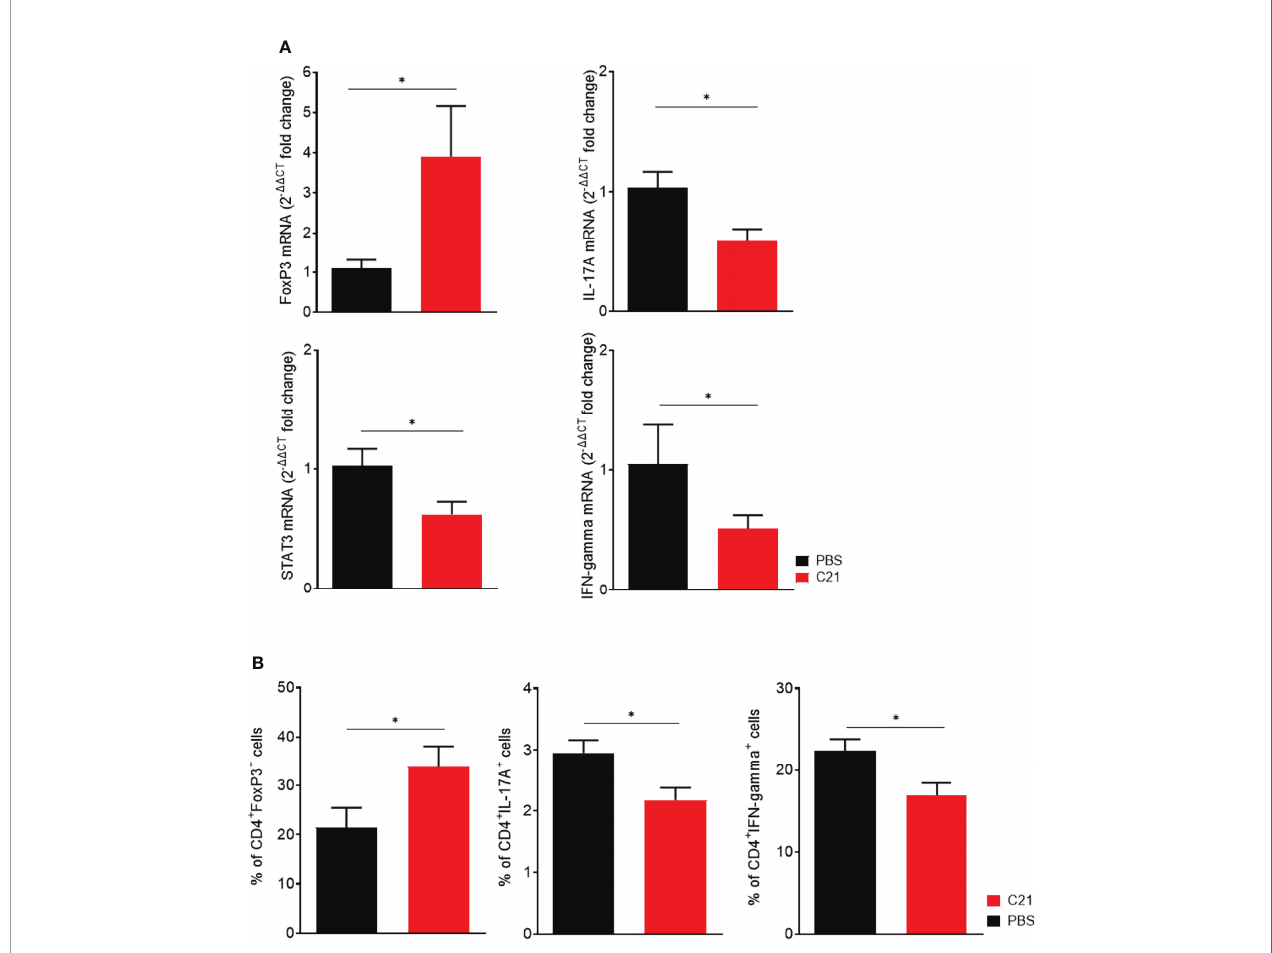
FIGURE 7 | In vitro , the presence of C21 suppresses Th17 and Th1 cell differentiation and induces Treg cell differentiation. Naïve T cells (CD4 + CD25 - CD62L + ) were isolated from C57BL6/J mice and polarized under Treg, Th17 and Th1 polarizing conditions for 6 days in the absence or presence of 1 µM C21. (A) Analysis of mRNA expression for FoxP3, IL-17A, STAT3 and IFN-gamma by real-time RT-PCR. Data were normalized for Hypoxanthin-Guanin-Phosphoribosyl-Transferase (HPRT) content. The PBS group was used as calibrator. Fold change expression was calculated by [2^(- DD CT)]. Data are shown from three biological replicates. (B) Flow cytometric analysis of polarized T cells for intracellular FoxP3 (Treg), IL-17A (Th17) and IFN-gamma (Th1) in CD4 + T cells. Data from four biological replicates are shown. P* < 0.05. All data were expressed as mean values ± SEM. P values were calculated by the nonparametric Mann – Whitney U